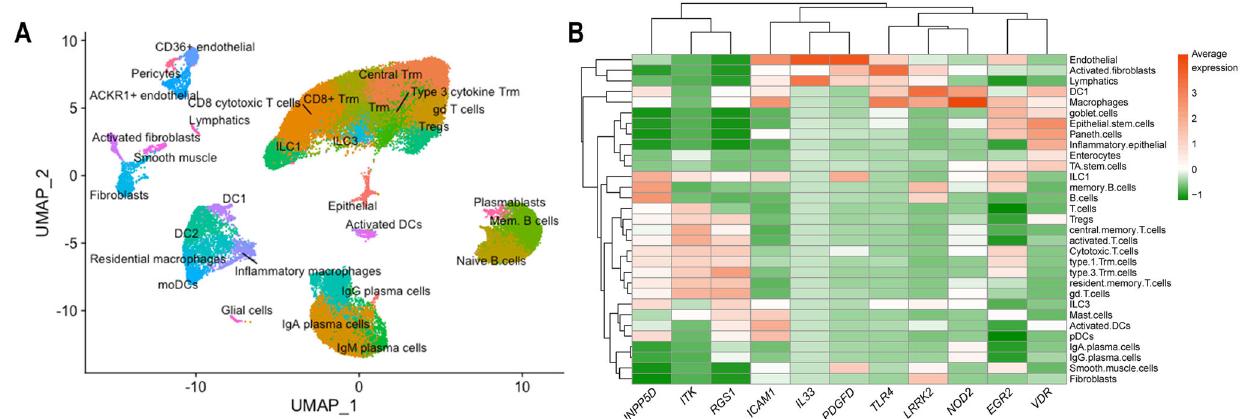
Fig. 4 | Single-cellRNA-seq analysesindicatethatthenine IBD genesidenti fi ed inthisstudyareexpressedinileumfromCrohn ’ sdiseasecases.A UMAPplotof clustered scRNA-seq cells from ileal CD in fl amed and unin fl amed samples which canbeannotated broadlyinto31celltypes. B scRNA-seqaverageexpressionofthe